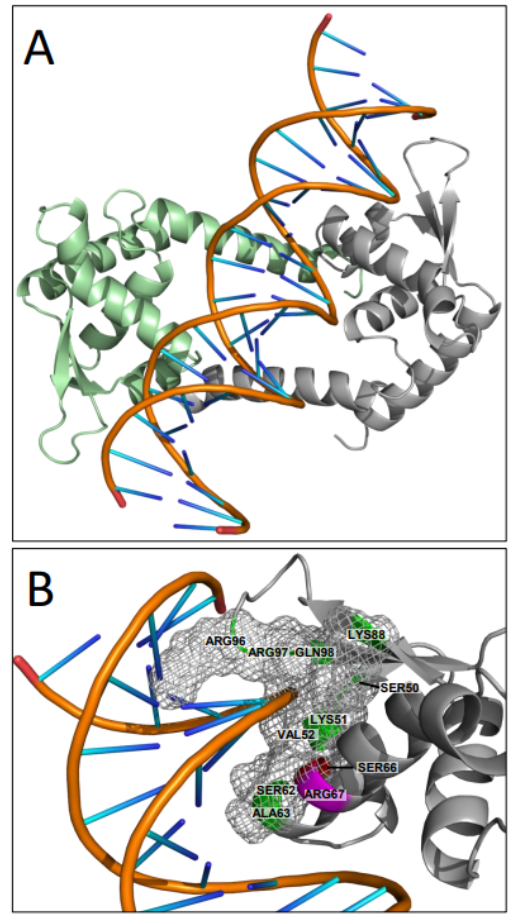
Figure 4. Homology structure model of pMarR-DNA complex. I-TASSER [30] structural und func- tional prediction of pMarR is based on a tertiary alignment with Salmonella enterica virulence regu- lator SlyA ([31], PDB ID: rq5F). ( A ) Schematic representation of dimeric pMarR (monomers are col- ored in green and grey) and from the co-crystallized 22-bp DNA duplex containing the SlyA 12-bp high-affinity binding site TTAGCAAGCTAA. ( B ) Putative protein-DNA interaction region. Amino